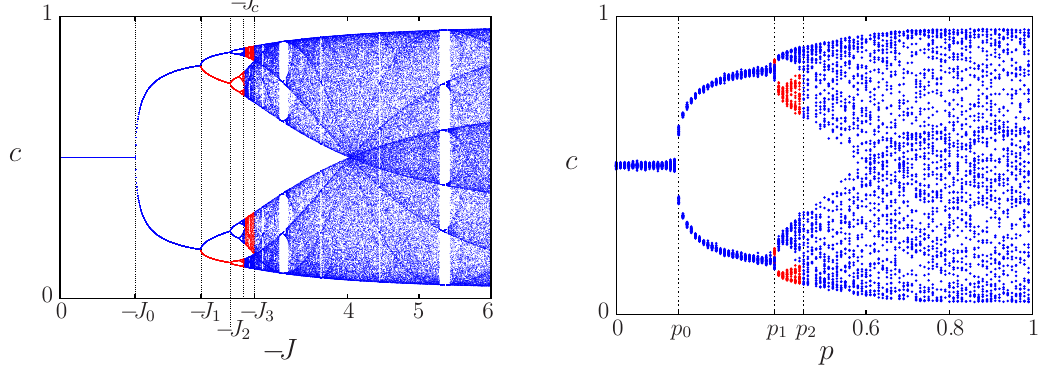
Figure 12. ( Left ) Bifurcation diagram of the mean-field map, Equation (9), by varying J ; and ( Right ) small-world probabilistic bifurcation diagrams as functions of the long range probability p . The colors mark different attractors. Figures from